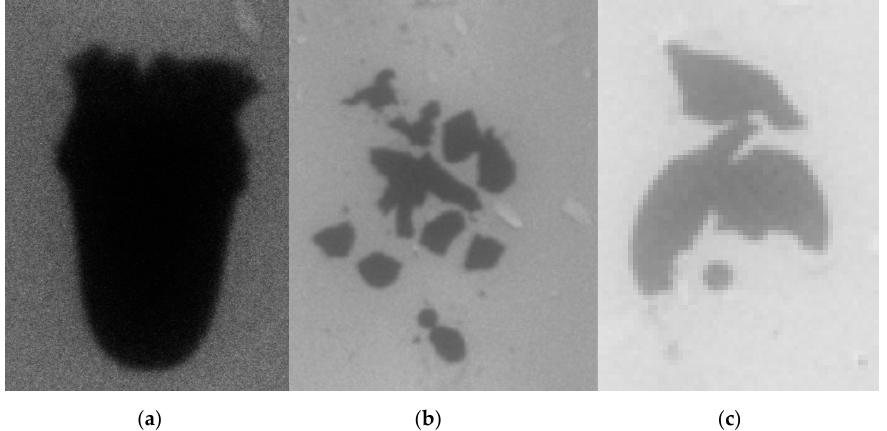
Figure 3. X-ray photographs of liners for different metal materials in the experiment. ( a ) Copper. ( b ) 90W–9Ni-Co. ( c ) W–25Re.